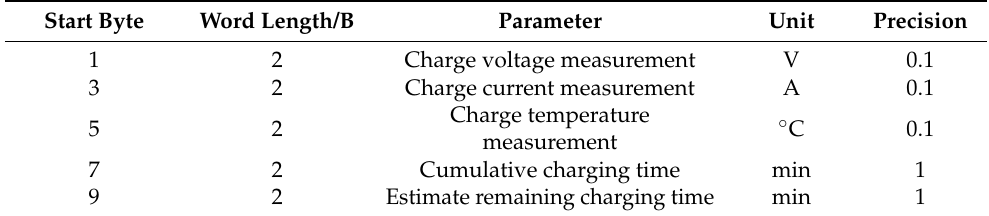
Table 2. Main status information during charging of the electric vehicle